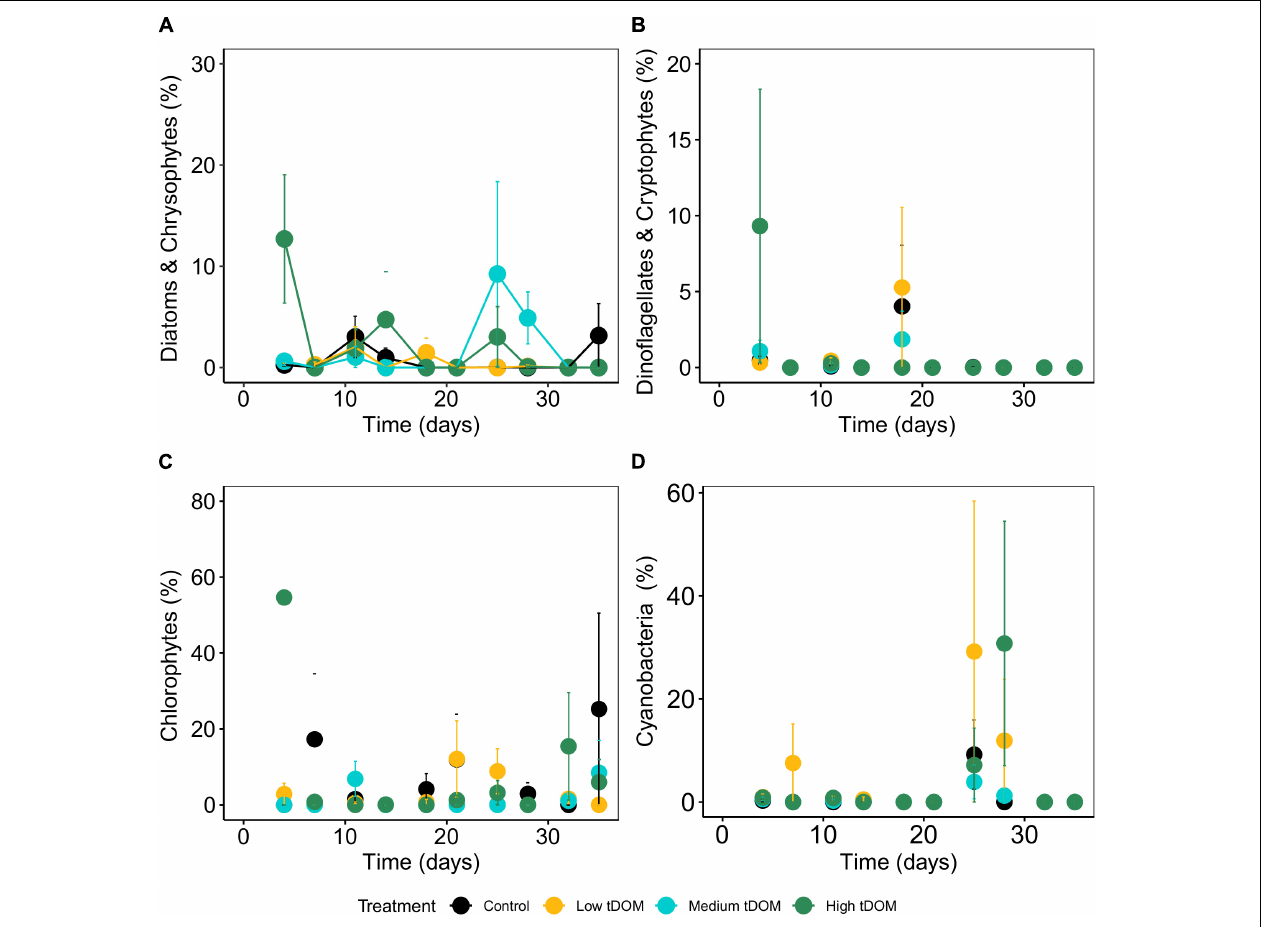
FIGURE 6 | Relative abundance of phytobenthos specific pigment signature composition (%) over 35 days of the experiment. (A) Diatom and chrysophytes, (B) dinoflagellates and cryptophytes, (C) chlorophytes and (D) cyanobacteria. Error bars represent standard deviation. Color plots represent tDOM addition in the control (black), low tDOM (yellow), medium tDOM (blue), and high tDOM (green)